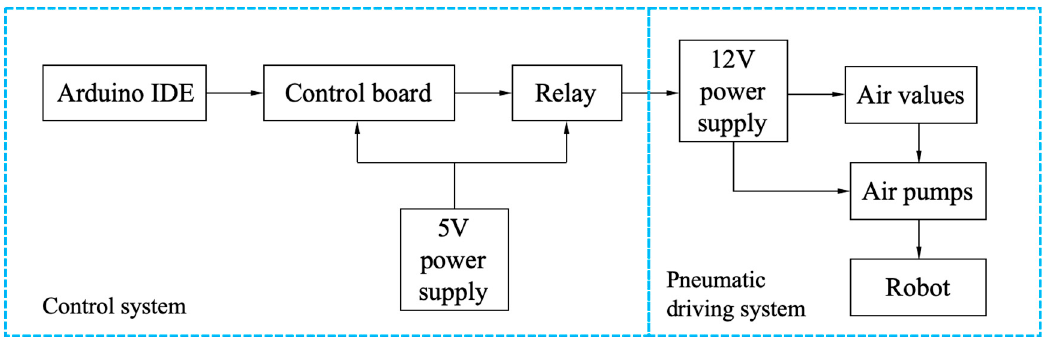
Figure 19. The control scheme diagram for the testing of the robot prototype.